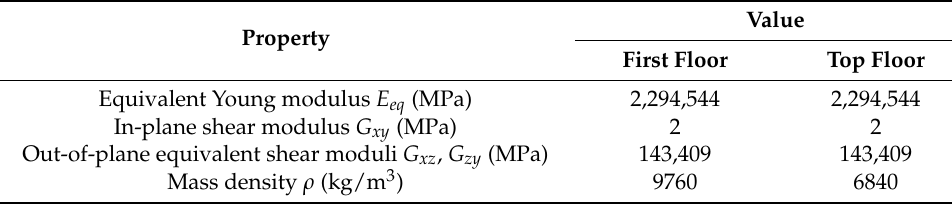
Table 5. Properties of the shell elements (thickness = 18 mm) representing the flexible diaphragms in configuration